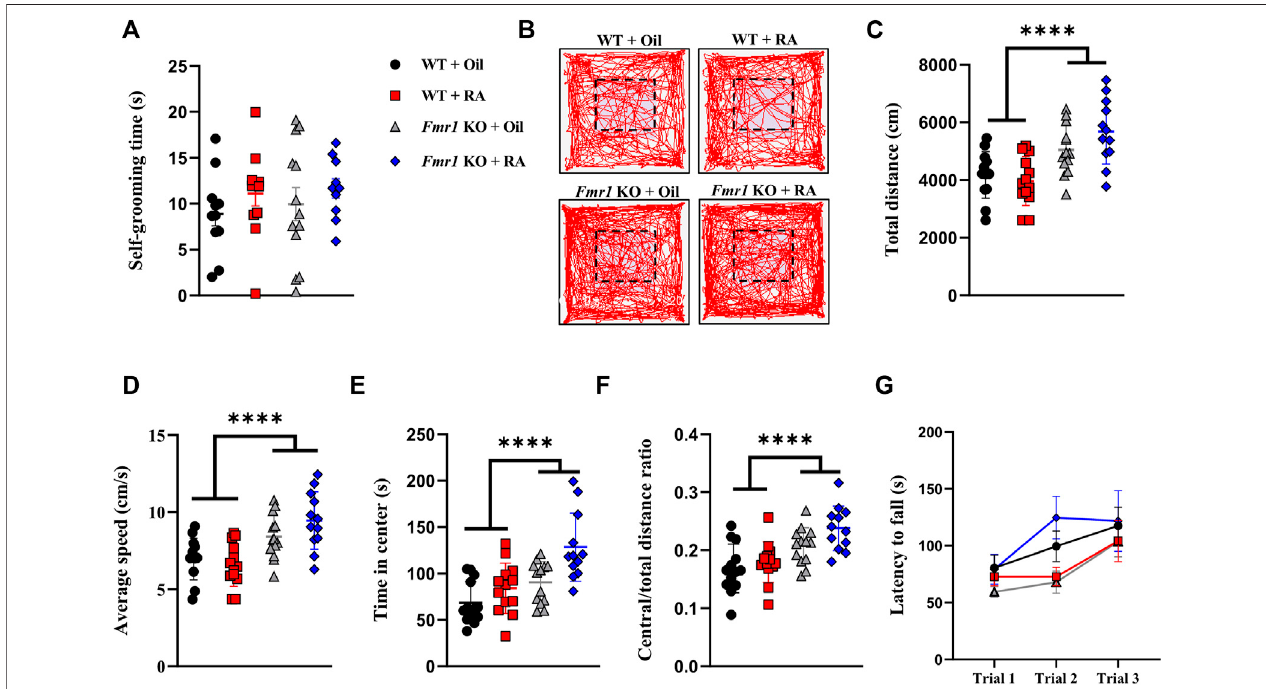
FIGURE3| RAadministrationdoesnotaffectrepetitivebehavior,locomotion,ormotorcoordinationin Fmr1 KOmice. (A) Timespentinself-groomingforrepetitive behavioraltestperformedwith4groupsofmice.WT+Oil(n=11),WT+RA(n=12), Fmr1 KO+Oil(n=13), Fmr1 KO+RA(n=10). (B – F) Representativeactivitytraces (B) ,totaldistancemoved (C) ,averagespeed (D) ,timespentincenter (E) ,andratioofcentraldistancetototaldistance (F) intheopen- fi eldtestperformedwith4groups of mice. The dotted line indicates the central area. WT + Oil (n = 13), WT + RA (n = 13), Fmr1 KO + Oil (n = 13), Fmr1 KO + RA (n = 12). (G) Latency to falling in